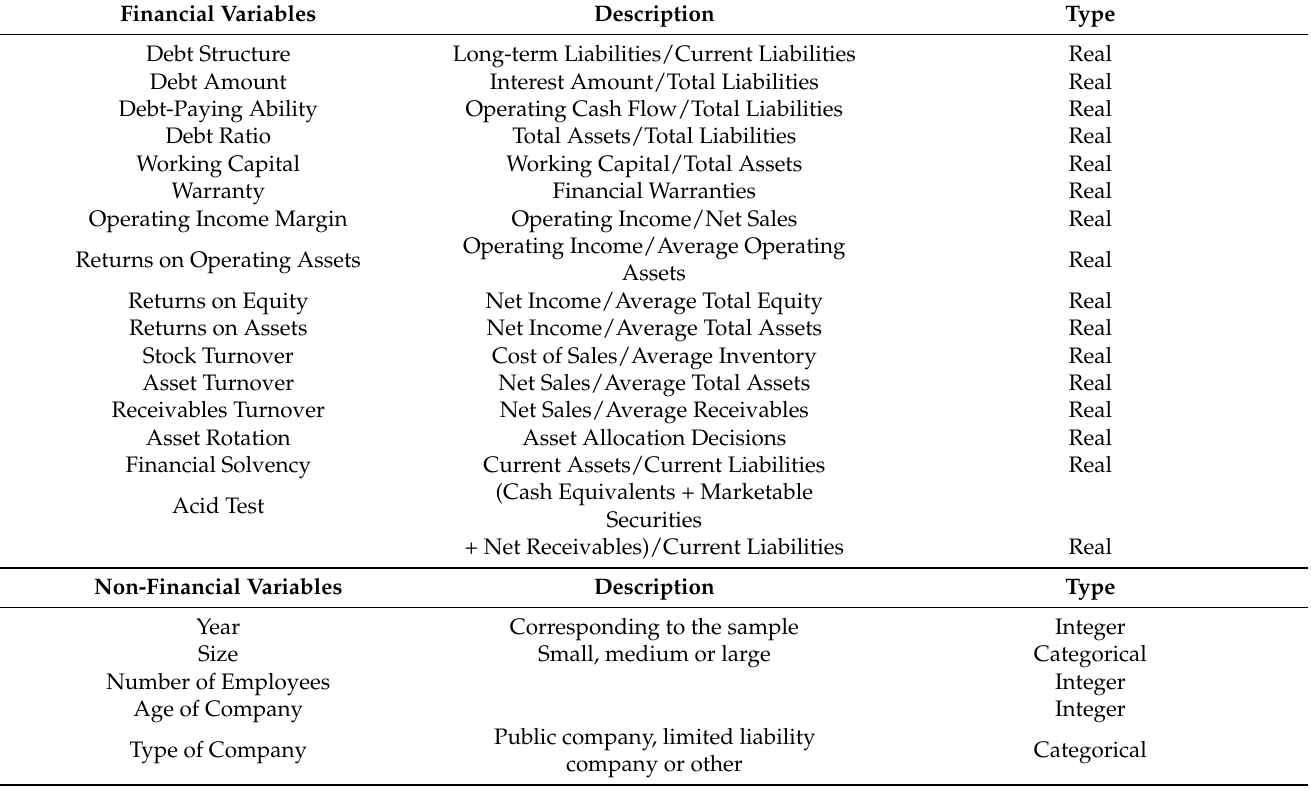
Table 1. The independent variables of the dataset of Spanish companies (financial and